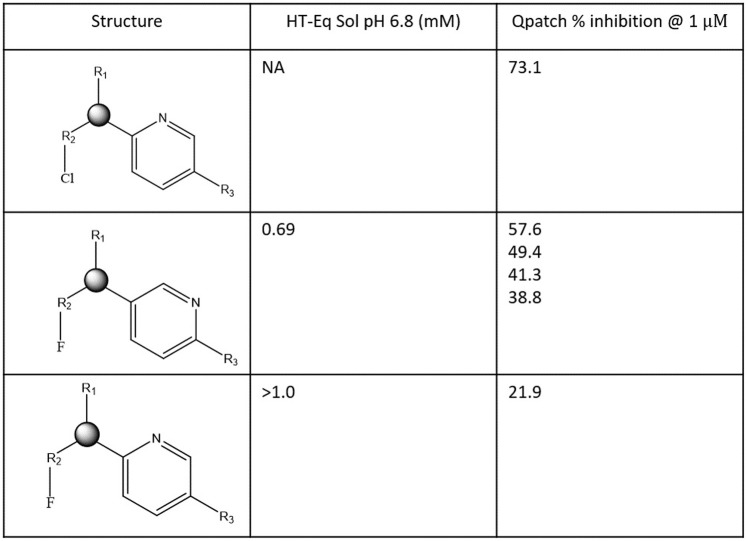
Representative activity cliffs for the proprietary hERG blocker series 1 (see text) comprised of R1 (corresponding to BP) and R2/R3 (corresponding to BC).The large decrease in percent inhibition @ 1 μM for structure 3 compared with structures 1 and 2 is putatively attributable to the greater re-solvation cost of Cl versus F, together with increased polarity and solubility/de-solvation cost of the ortho- versus meta-pyridyl nitrogen, (consistent with the lack of hERG-contributed H-bond replacements for the water solvating this moiety in the unbound state).